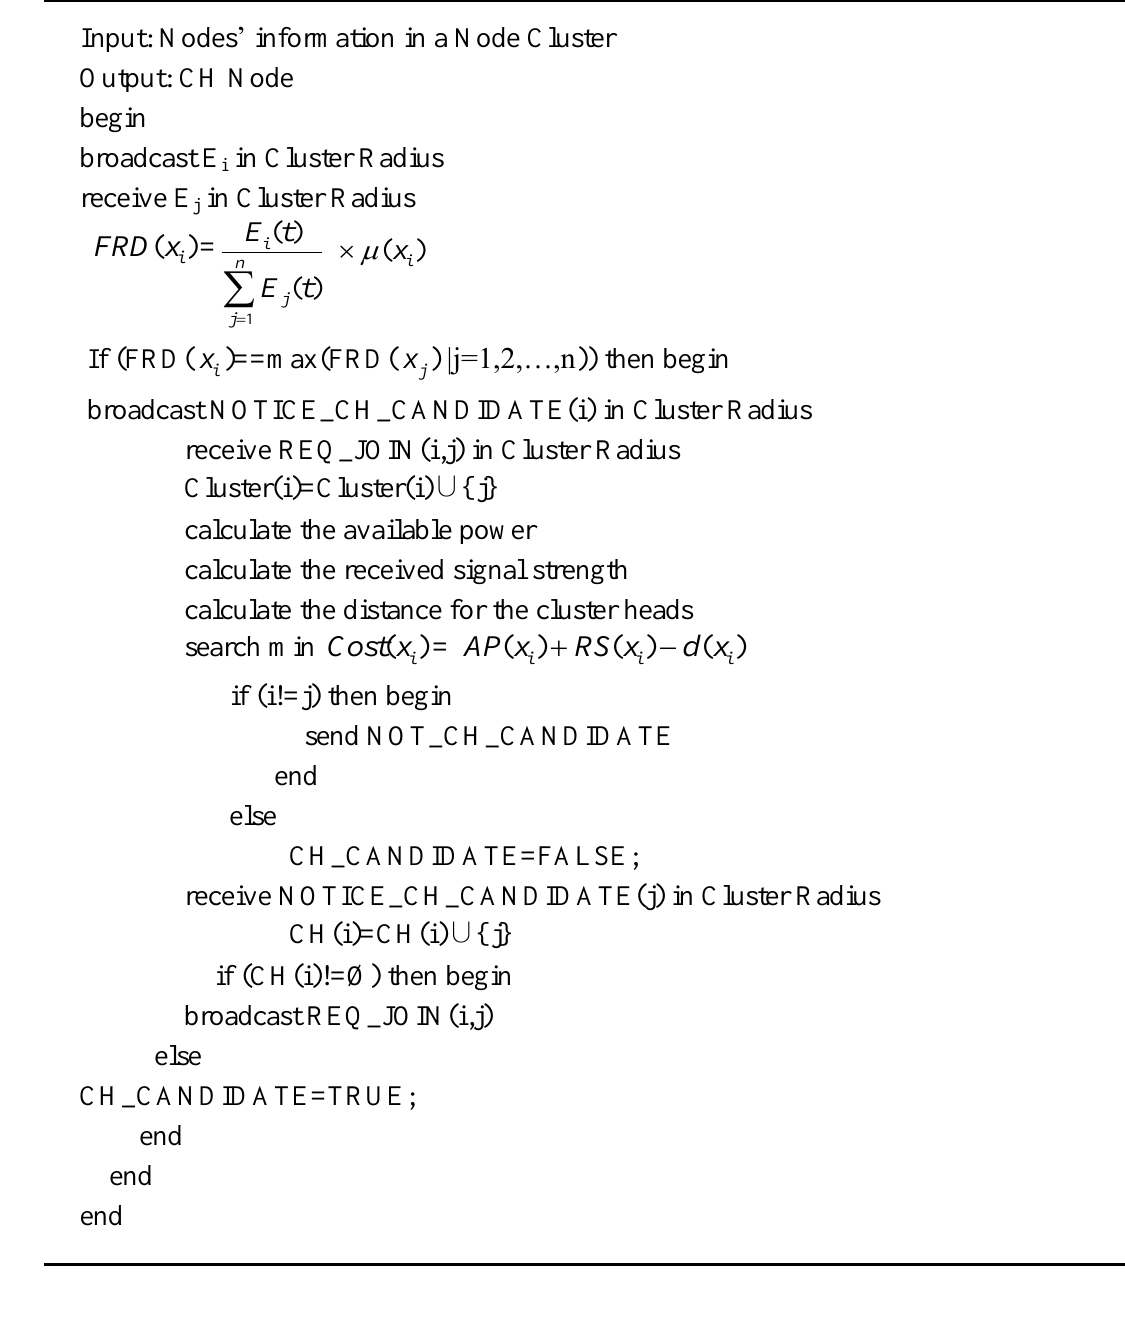
Algorithm 1. Cluster head